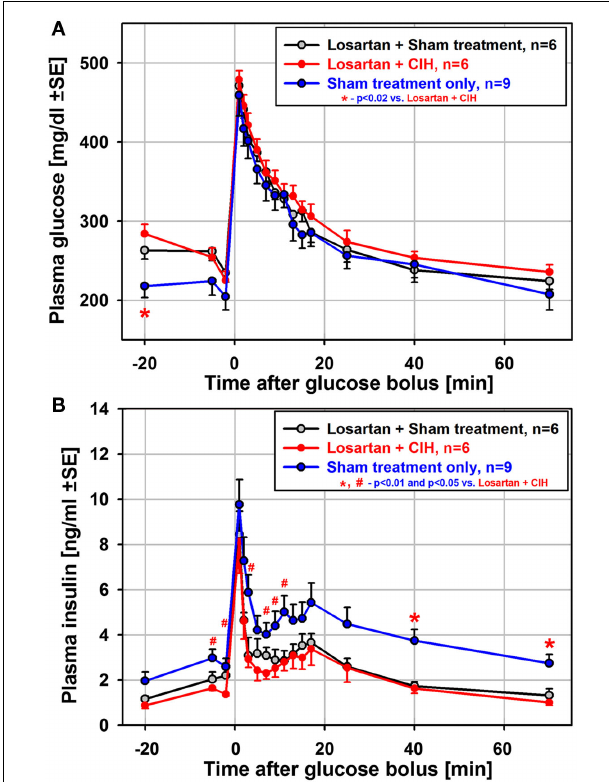
FIGURE 5 | Mean glucose and insulin curves obtained from the ivgtt conducted under anesthesia with six rats subjected to CIH and six rats subjected to sham gas exchanges for 35days with concurrent daily administration of the angiotensin type 1 receptor antagonist, losartan. Losartan treatment eliminated all differences between CIH and sham-treated rats that occurred following CIH exposures of the same or shorter durations without losartan. Losartan also shifted upward the baseline glucose level and shifted downward the baseline insulin level when compared to the rats sham-exposed for 35days without losartan [blue lines in (A) and (B) ].Thus, insulin sensitivity was improved in losartan-treated animals. See text for further